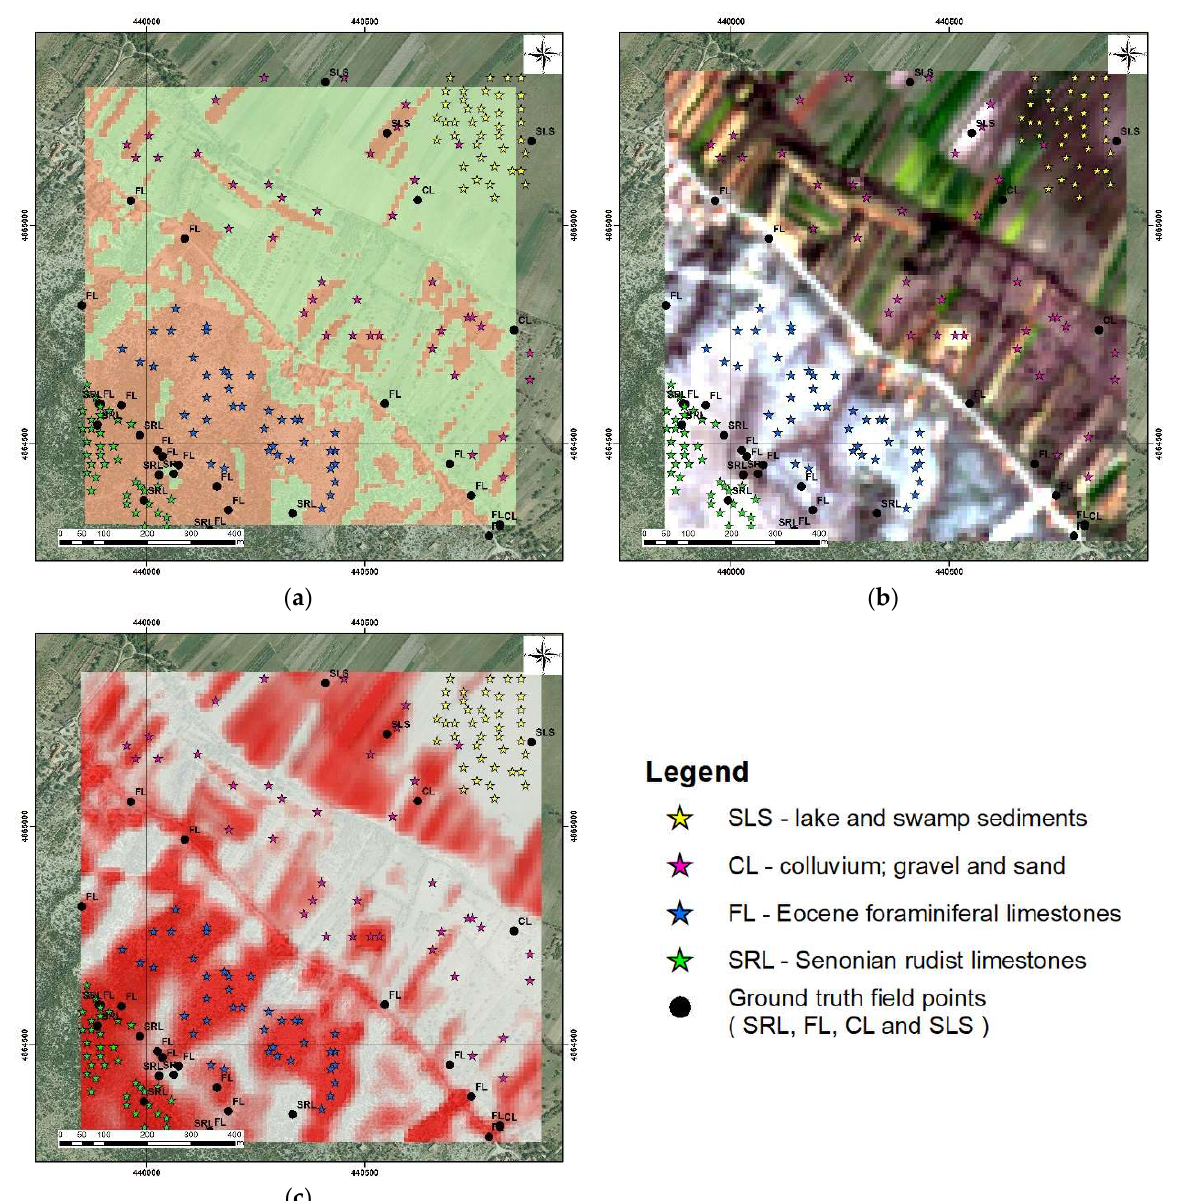
Figure 4. Selection points (pins) for spectral signature reading regarding Subset 1 site; ( a ) DOF is in the background. Green area represents vegetation, and orange area represents rocks and other landforms, all based on NDVI analysis; ( b ) RGB composite based on MSI S-2A imagery; ( c ) raster dataset derived from USGS spectral index on limestones.